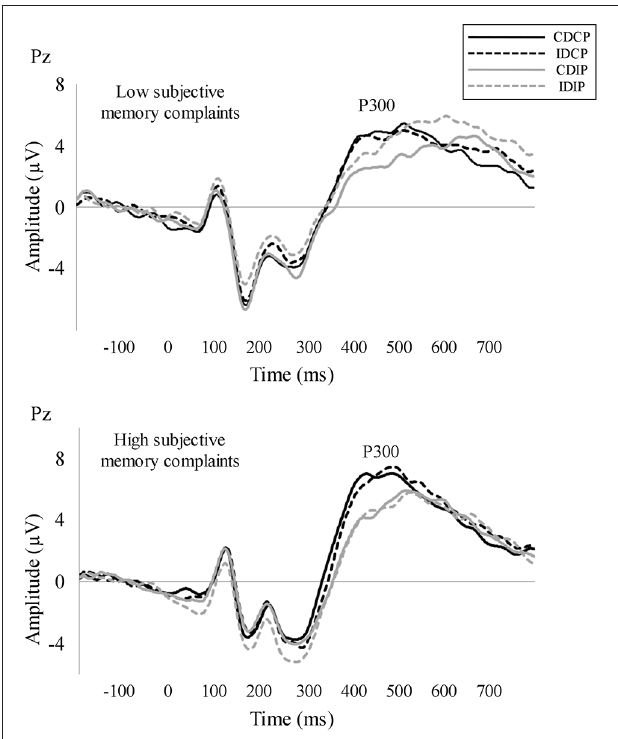
FIGURE 4 | Response-locked averages. Medial Frontal Negativity (MFN) was measured in a pool of fronto-central electrodes. In the HSMC group, MFN amplitude was larger in those conditions where the stimulus position and/or the direction pointed by the arrow were spatially incompatible with the required